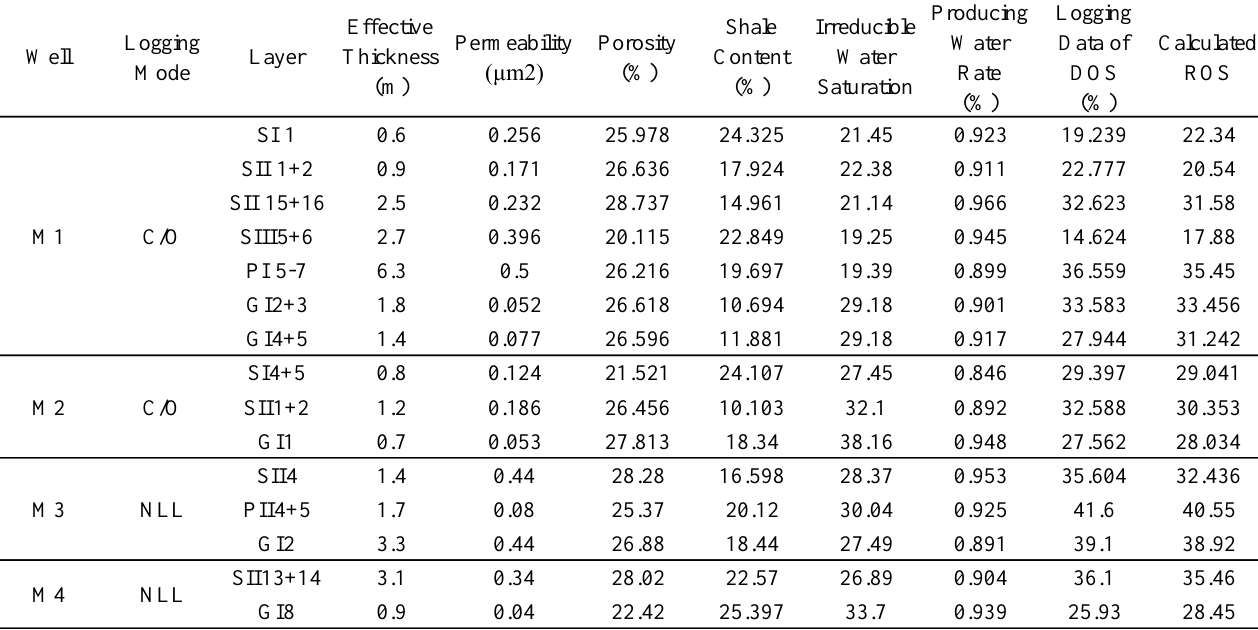
Table 1—2009 Logging data and calculation value